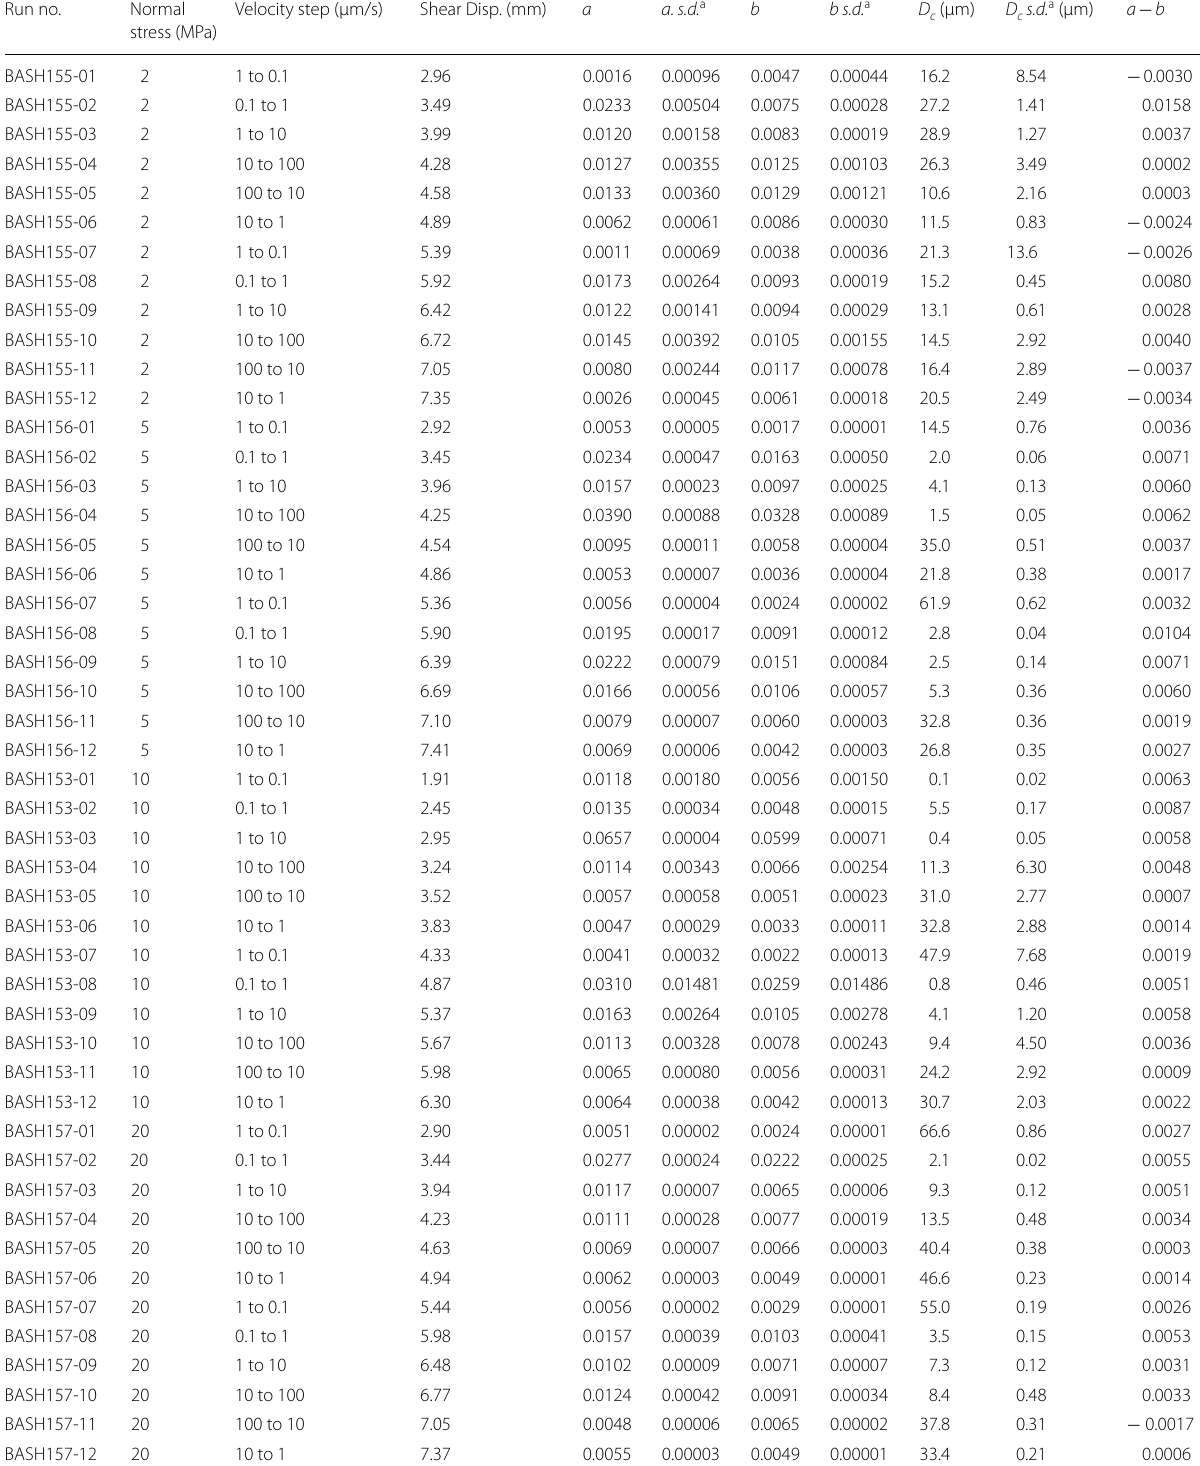
a Standard deviation of friction parameters